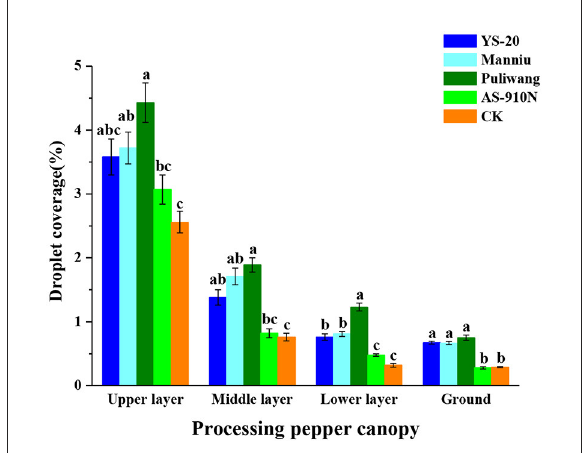
FIGURE5 Effect of aerial spray with adjuvants on the droplet density sprayed by UAV. a − c They represent the results of a significant difference analysis by Duncan’s new multiple range test at the level of P < 0.05. Values followed by the same letter do not differ statistically.